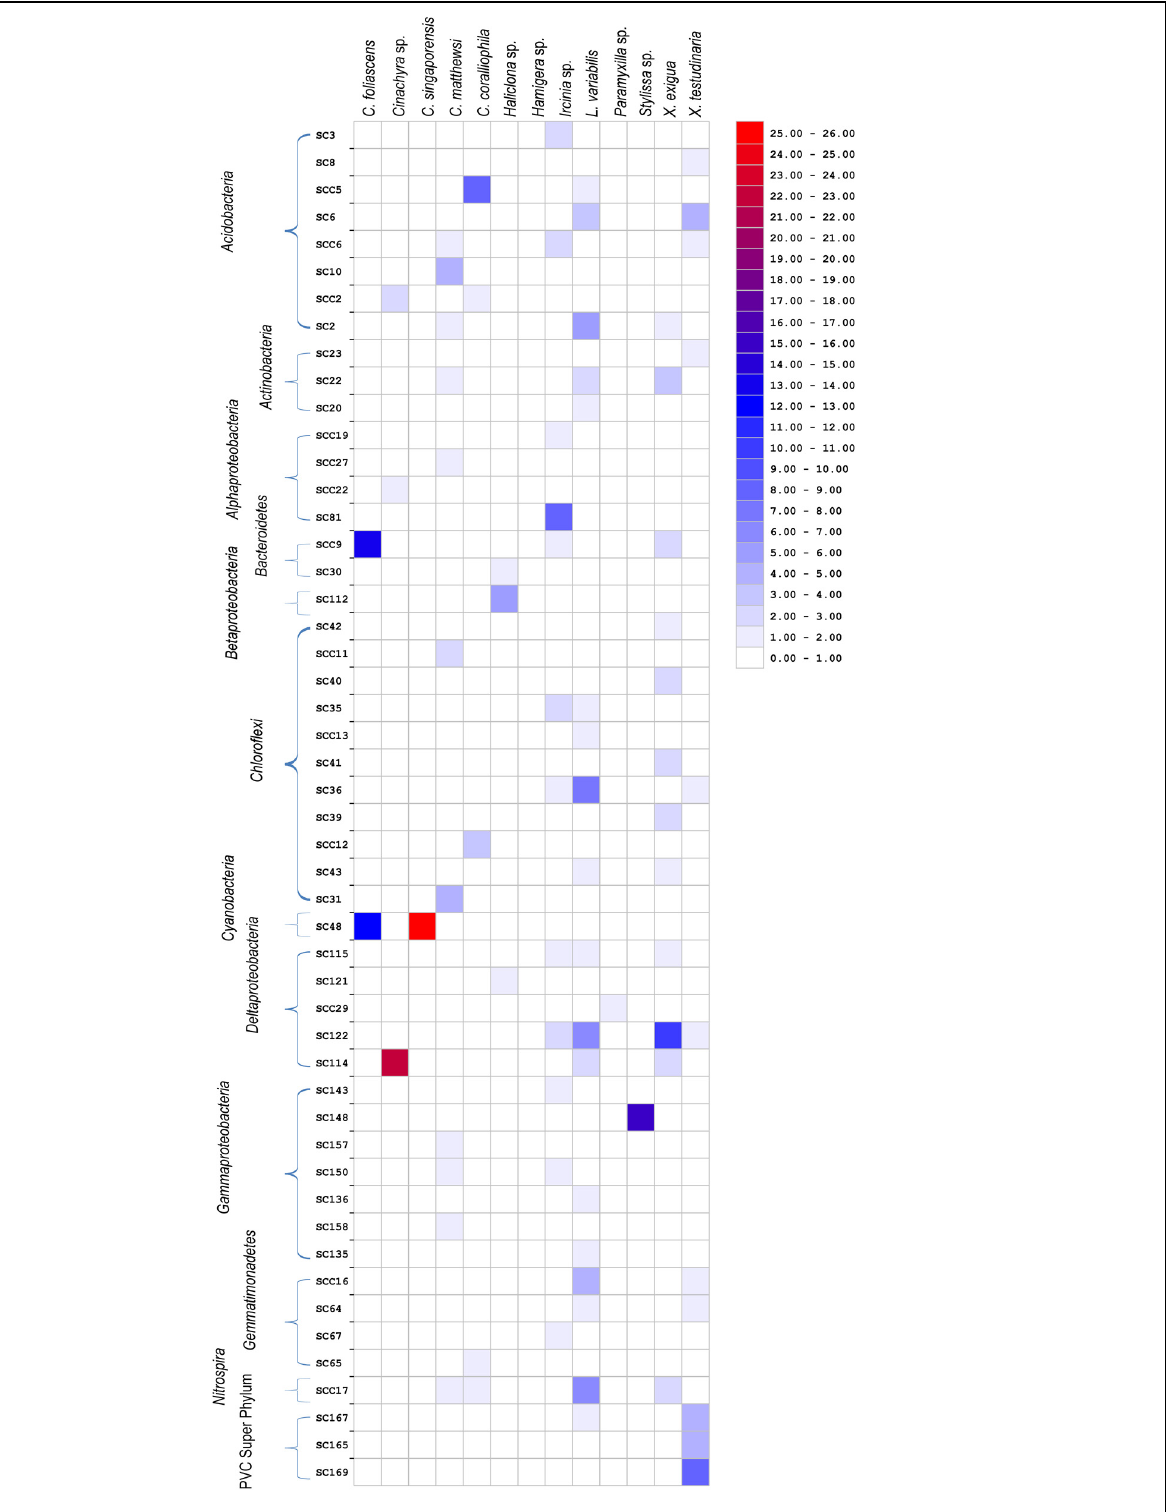
FIGURE 5 | Heatmap showing the distribution of clone sequences phylogenetically assigned to previously described “sponge-specific” 16S rRNA gene sequence clusters (Simister et al., 2012a) among the 13 different sponge species. Clusters with an SC prefix contain sequences